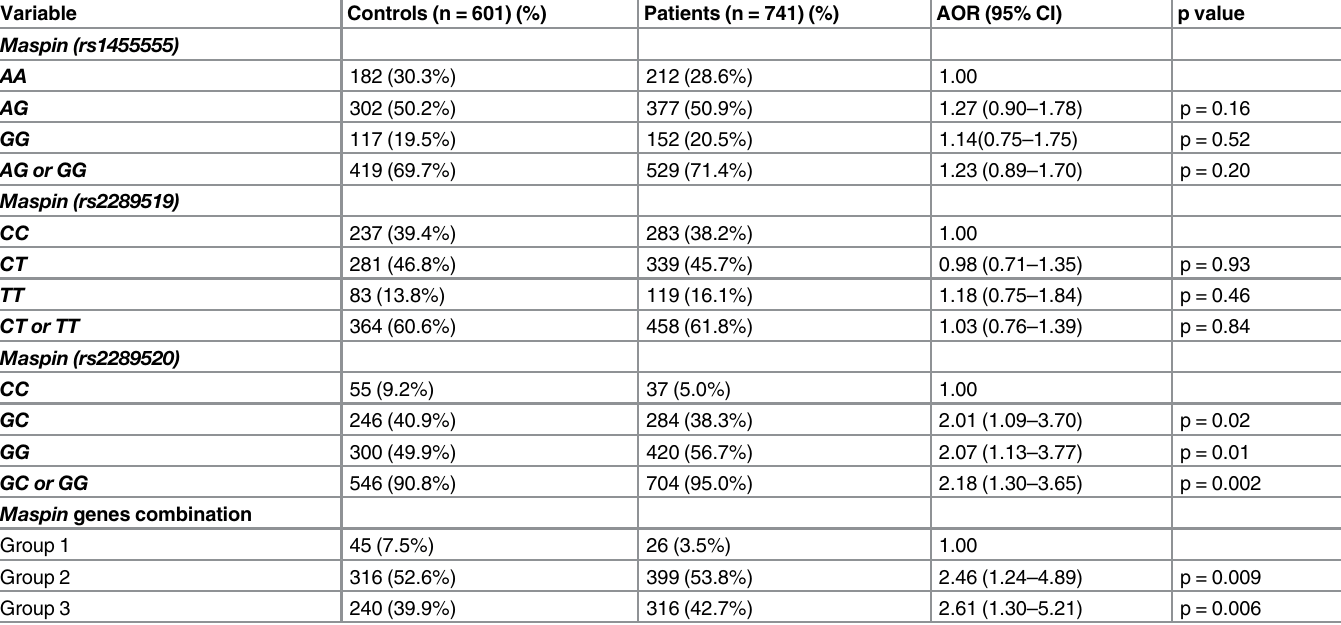
Table 2. Adjusted odds ratio (AOR) and 95% confidence intervals (CIs) of oral cancer associated with genotypic frequencies of Maspin .